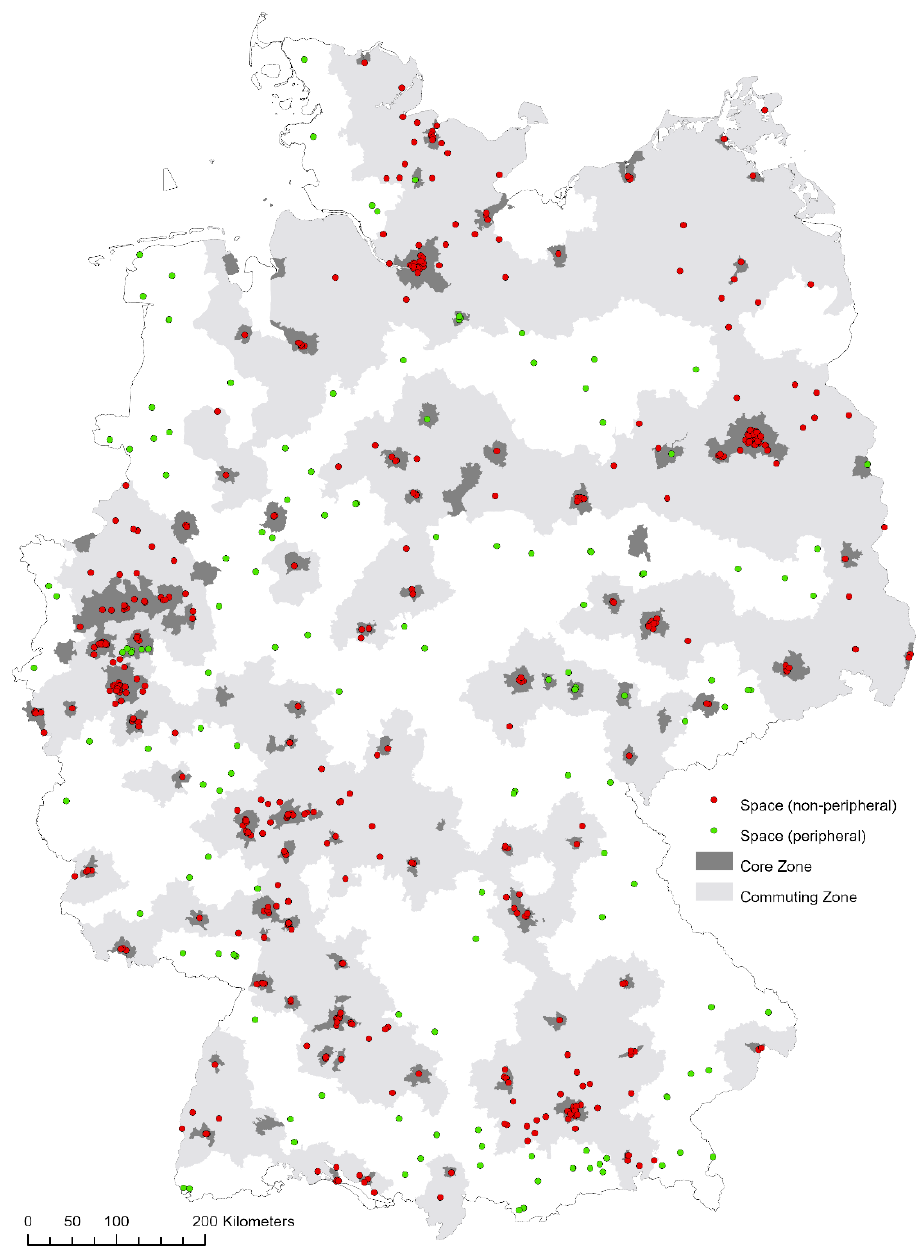
Figure 1. Location of coworking spaces (green dots: in peripheral areas, red dots: in non-peripheral areas, dark grey: core zones, light grey: commuting zones) in Germany interlaced with the FAUs defined by the OECD, source: own illustration based on © GeoBasis-DE/BKG (2020), www.coworkingmap.de (accessed on:04. June 2021).